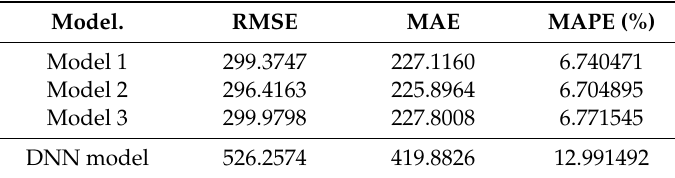
Table 2. Configuration data for the optimization